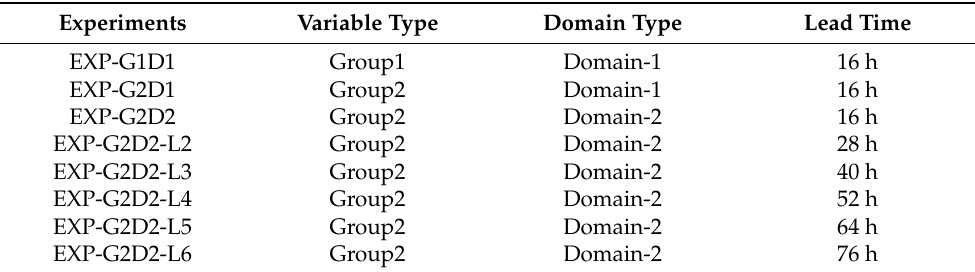
Table 2. List of